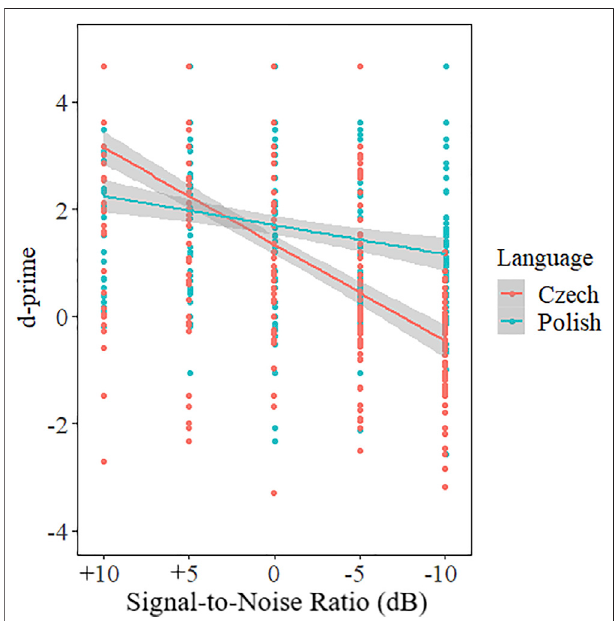
FIGURE 4 | Scatterplot ofthe interaction ofLanguage × Signal-to-Noise with regression lines.